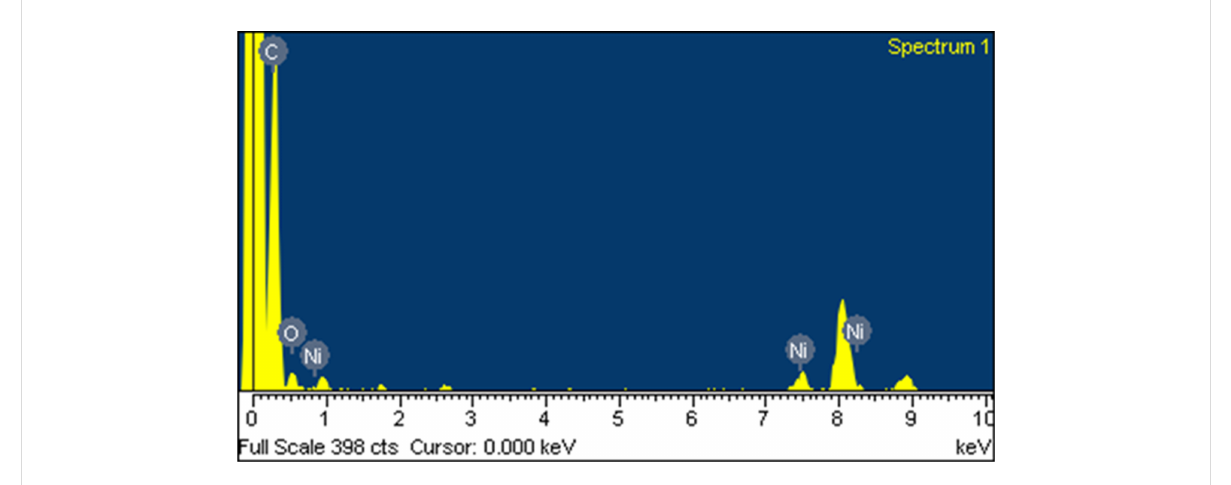
Figure 4: EDX spectrum of the Ni–chitosan NPs.